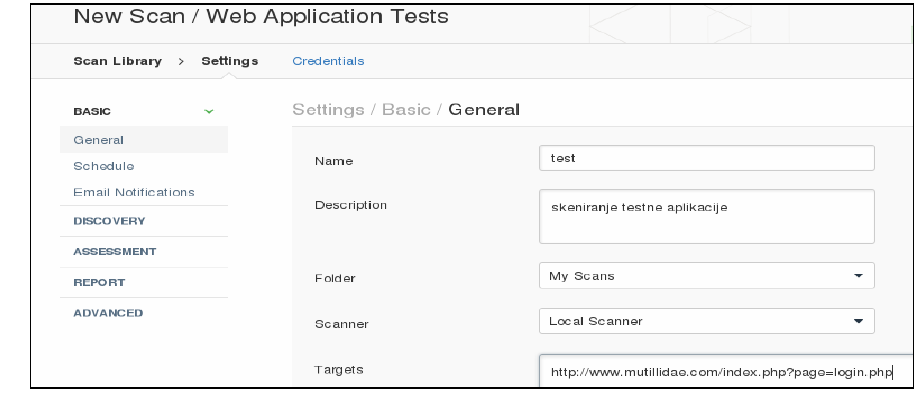
Figure 10 – Nessus – data entry Рис . 10 – Nessus – ввод